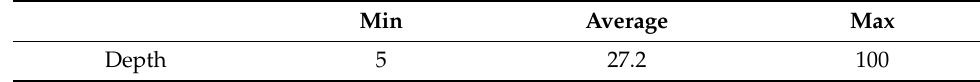
Table 2. Minimum, mean and maximum